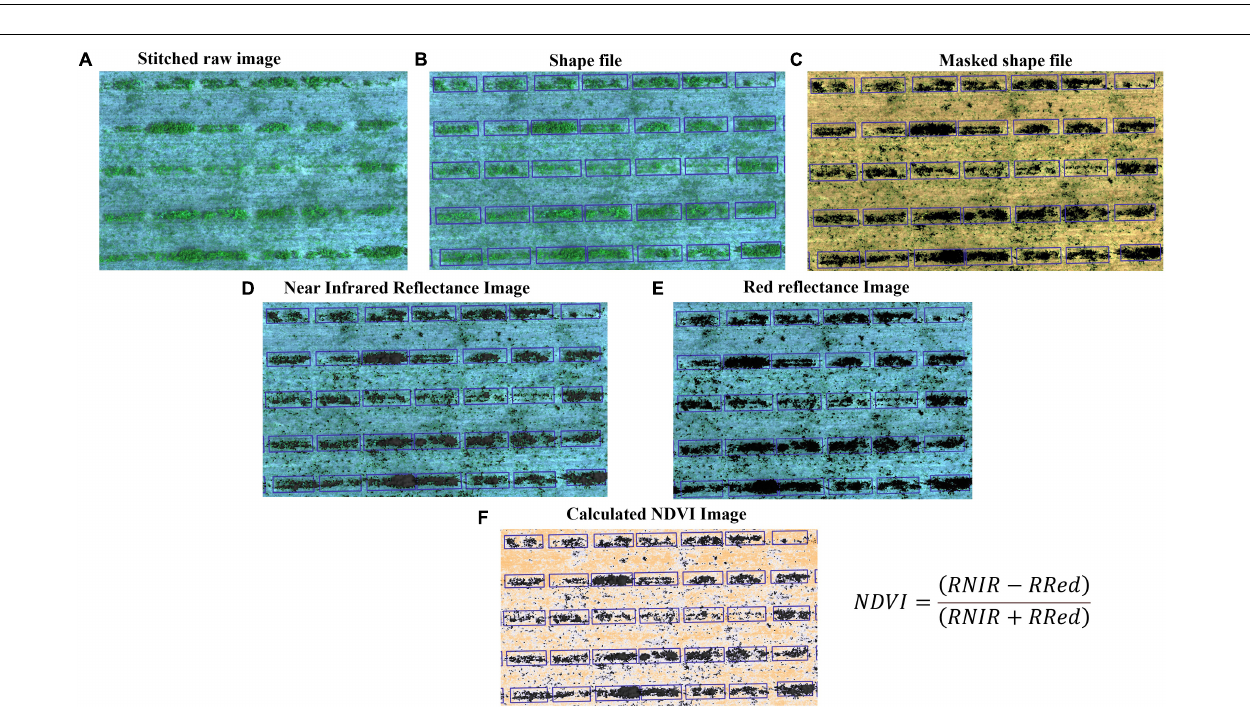
FIGURE 1 | Phenotyping alfalfa for: (A) ground-based herbage accumulation (HA); and (B) High-throughput phenotyping (HTP) using an unmanned aerial vehicle (Matrice 100) with multispectral camera (MicaSense RedEdge, Seattle, WA, United States) taking off in the experimental area.